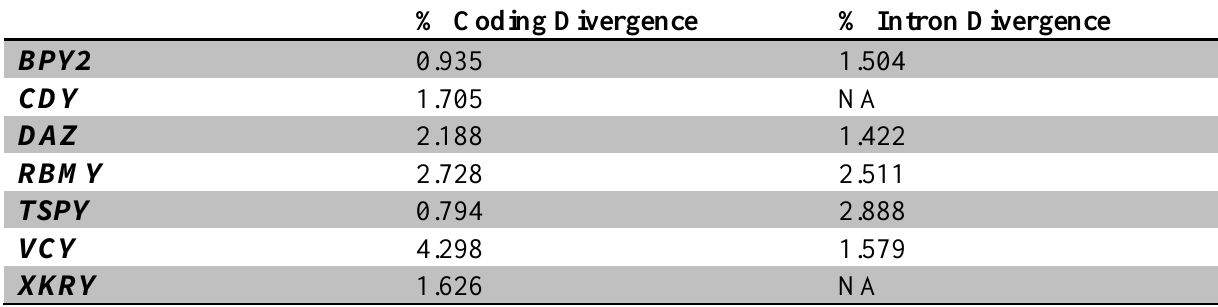
Table 2. Divergence of human and chimpanzee ampliconic gene sequences. All data are from [18]; NA = not